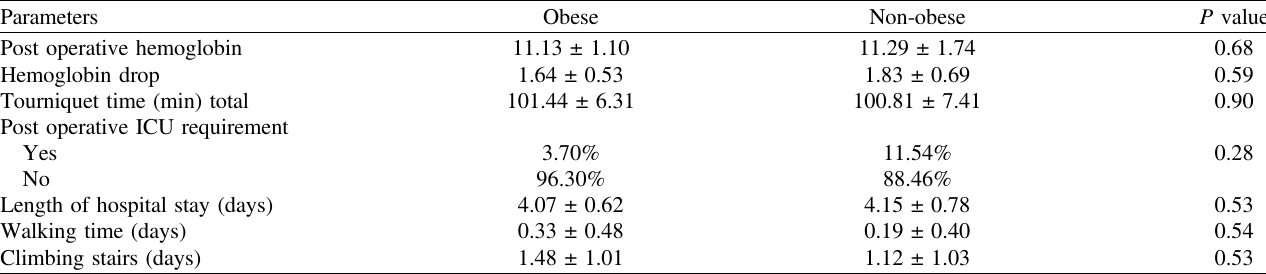
Table 2. Post-operative parameters ’ comparison of the two groups. Parameters